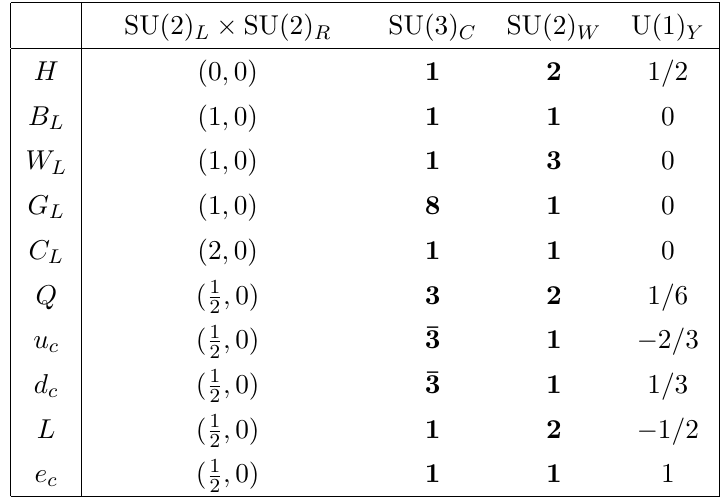
Table 1 . Representations of the spurions under the Lorentz and SM gauge